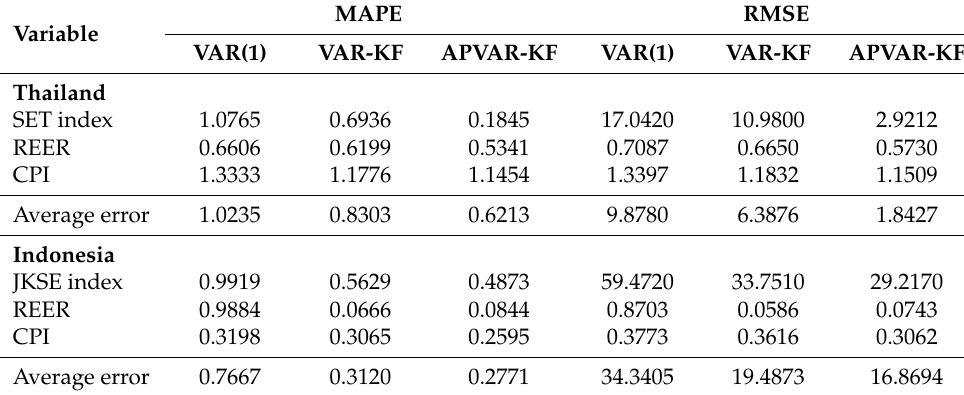
Table 5. Mean absolute percentage errors and root mean square errors of April